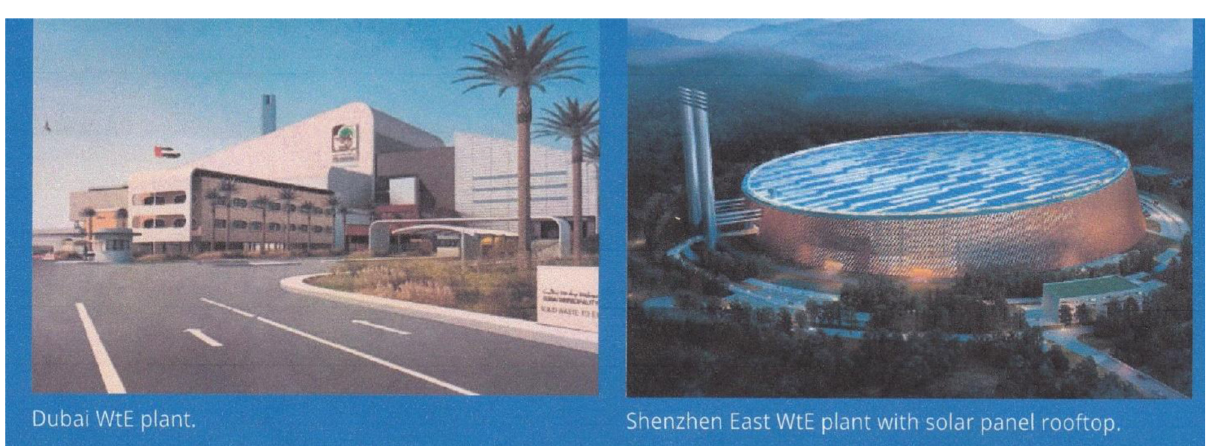
Fig. 10. Dubai WtE largest plant and Shenzhen (cid:1) East largest plant with PV on top